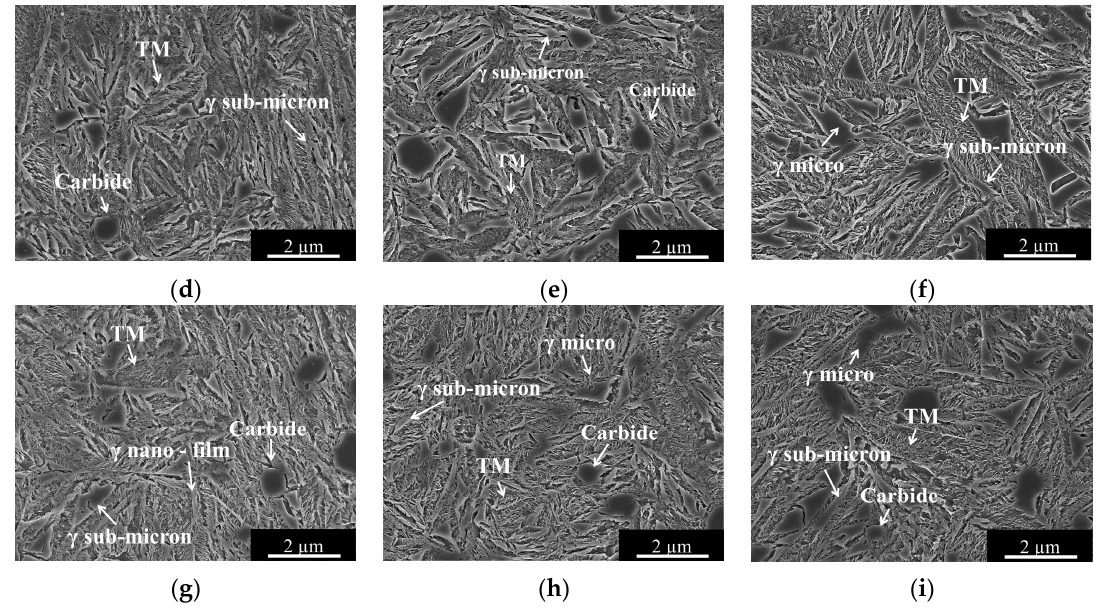
Figure 3. Field emission gun (FEG)-SEM micrographs for samples austenitized at 900 °C for 30 min and isothermally transformed in Nanobain bearing steel at ( a ) 230, ( b ) 280, and ( c ) 350 °C; Q&P samples isothermally treated at ( d ) 230, ( e ) 280, and ( f ) 350 °C; and Q&T samples isothermally treated at ( g ) 230, ( h ) 280, and ( i ) 350 °C. Coarse carbides are undissolved primary iron carbides; TM denotes tempered martensite.